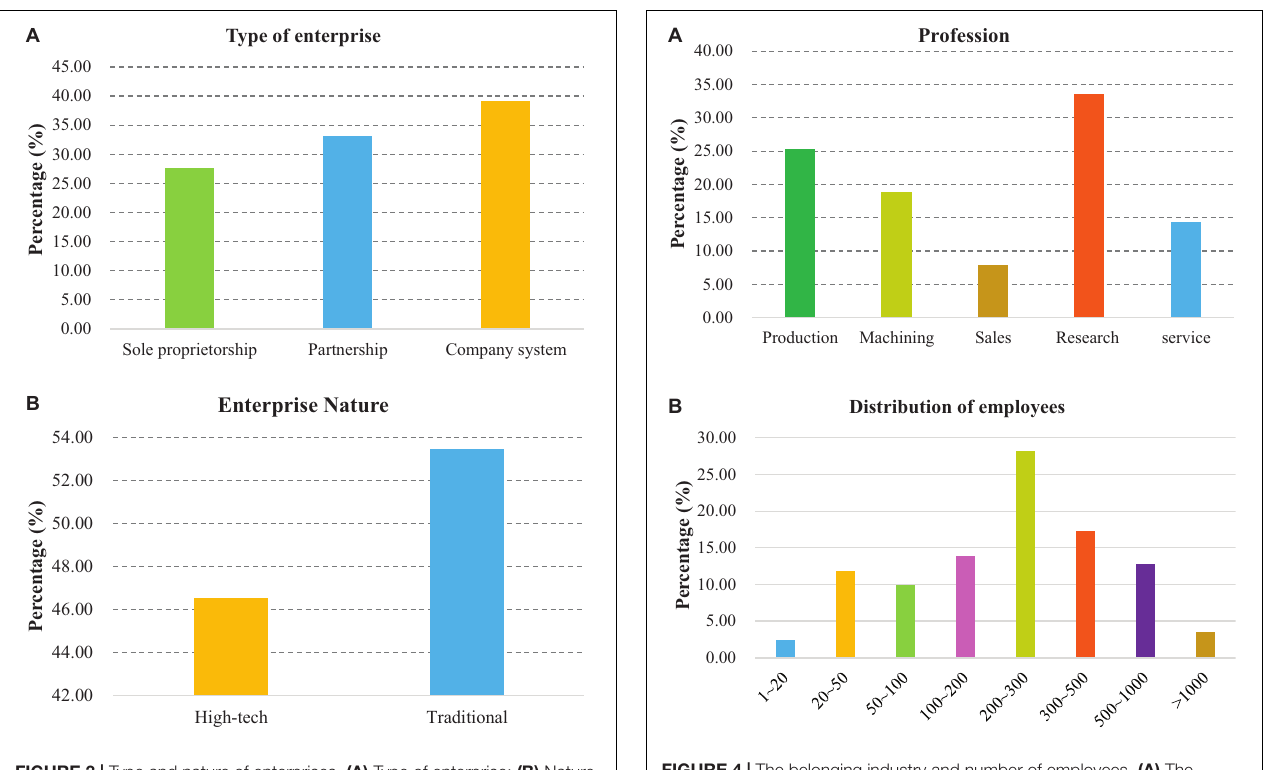
FIGURE 3 | Type and nature of enterprises. (A) Type of enterprise; (B) Nature of enterprise.